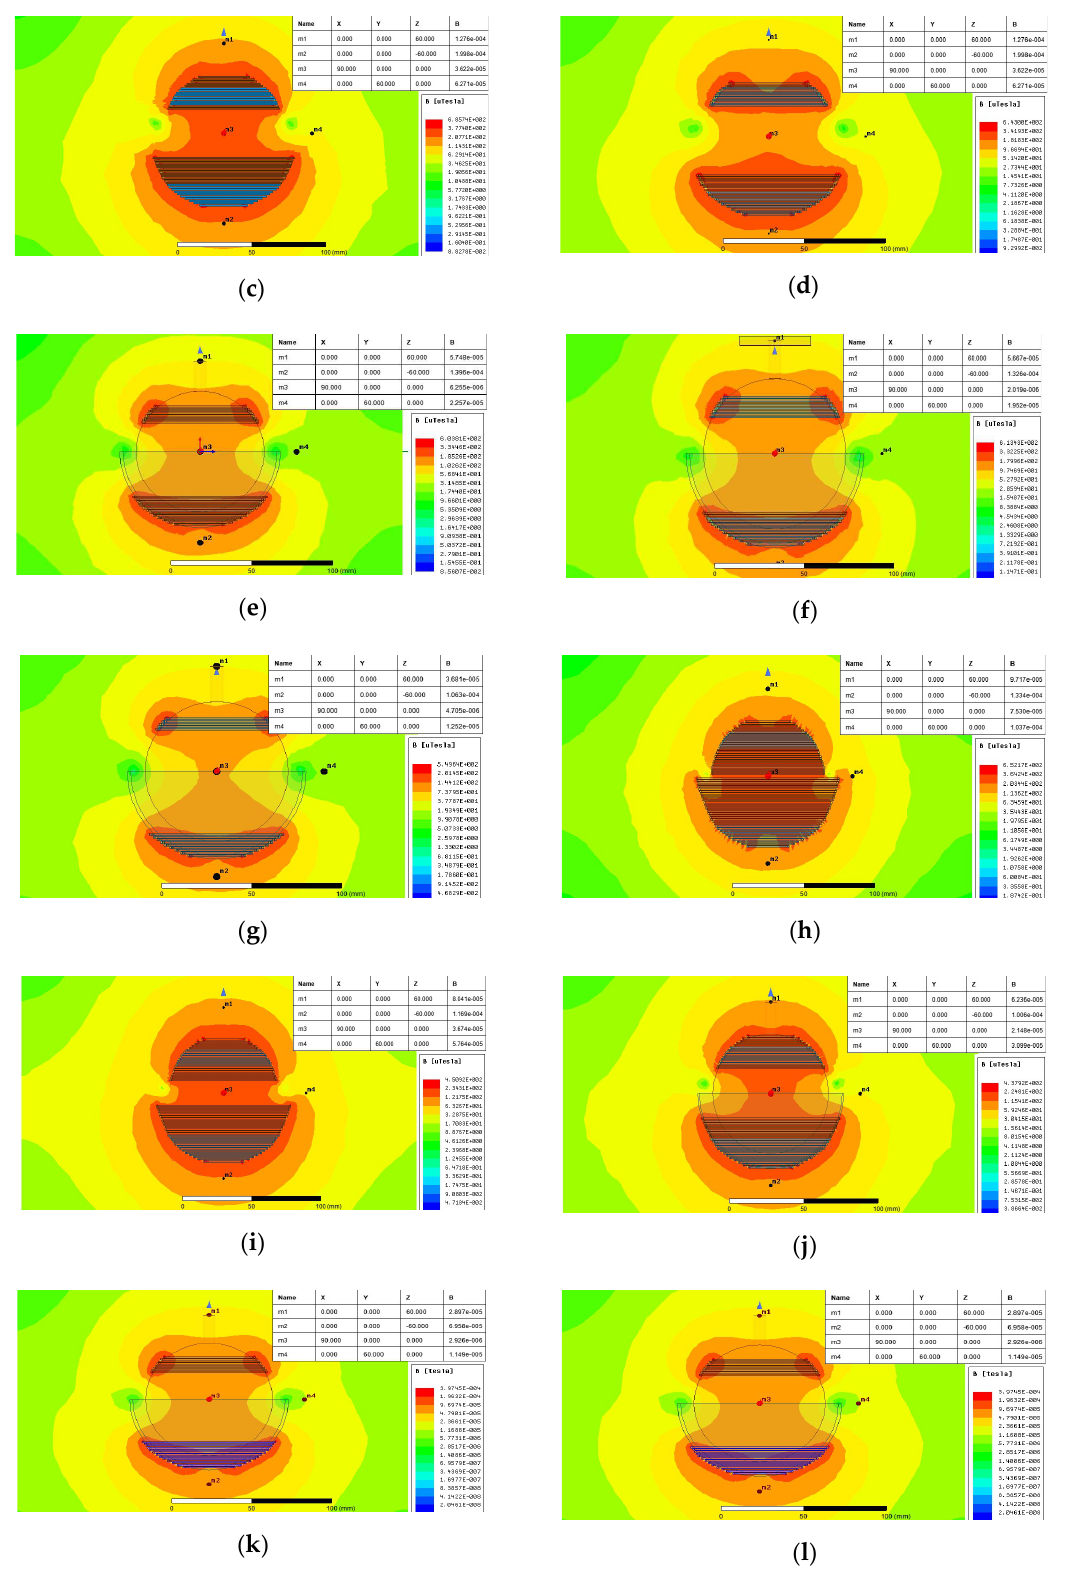
Figure 4. Winding methods ( N Tx , N Rx ) and magnetic-field densities taken at four positions. ( a ) Double layer (DL) (64, 50). ( b ) DL (54, 40). ( c ) DL (44, 30). ( d ) DL (34, 20). ( e ) DL (26, 16). ( f ) DL (24, 16). ( g ) DL (18, 10). ( h ) Single layer (SL) (32, 25). ( i ) SL (27, 20). ( j ) SL (22, 15). ( k ) SL (22, 15). ( l ) SL (13, 8) (conducted with Ansys Maxwell 3D, PA, USA).